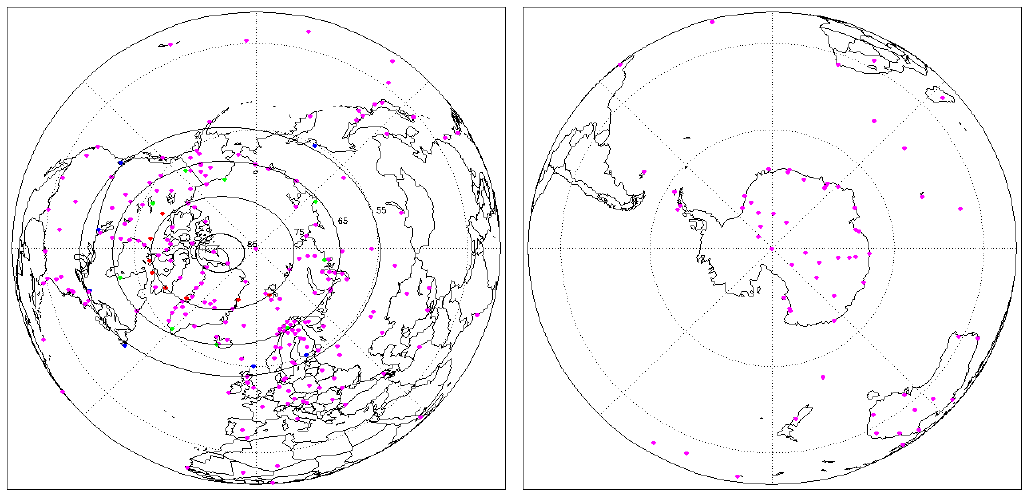
Figure 1: Pole-centric maps of the (left) northern and (right) southern hemispheres showing the locations of known operating magnetometer stations in 1996 (coloured dots), as compiled by the World Data Centre, C1 for Solar Terrestrial Physics, RAL Space,